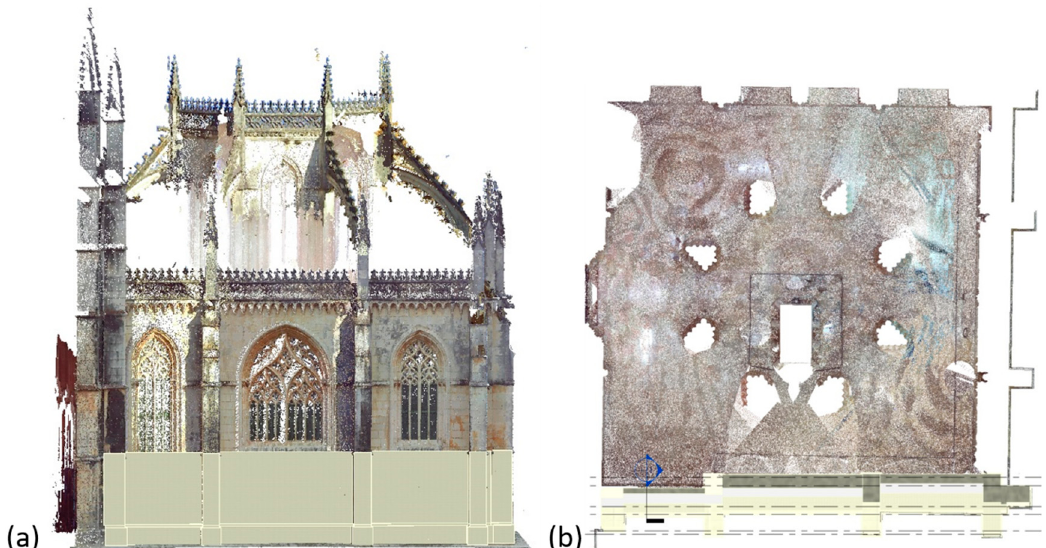
Figure 13. ( a ) Three-dimensional view of the wall object of the façade, ( b ) plan view of the point clouds superposed to this wall object.